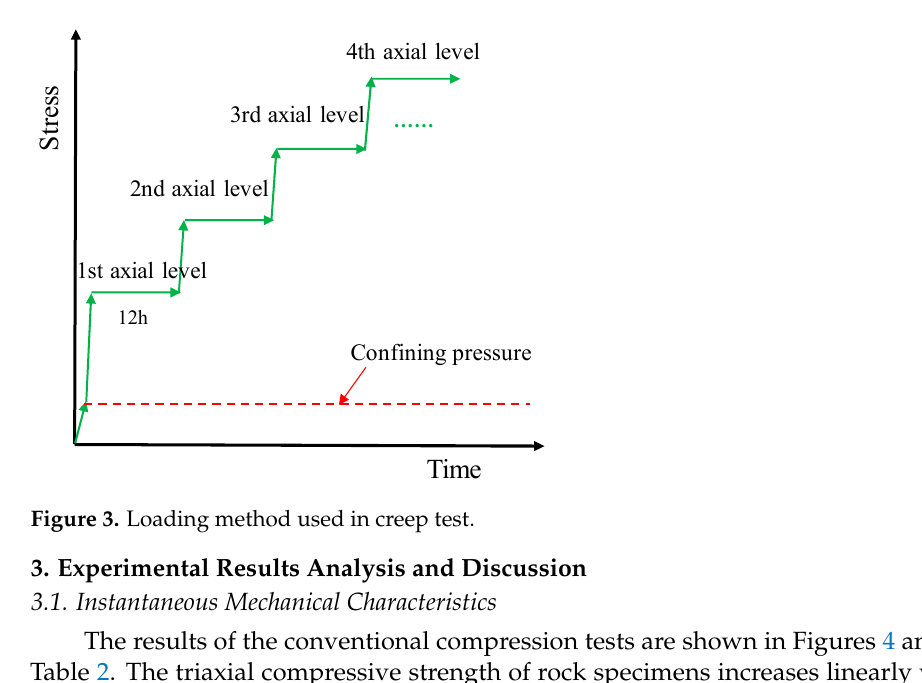
Table 2. Results of conventional triaxial compression tests.